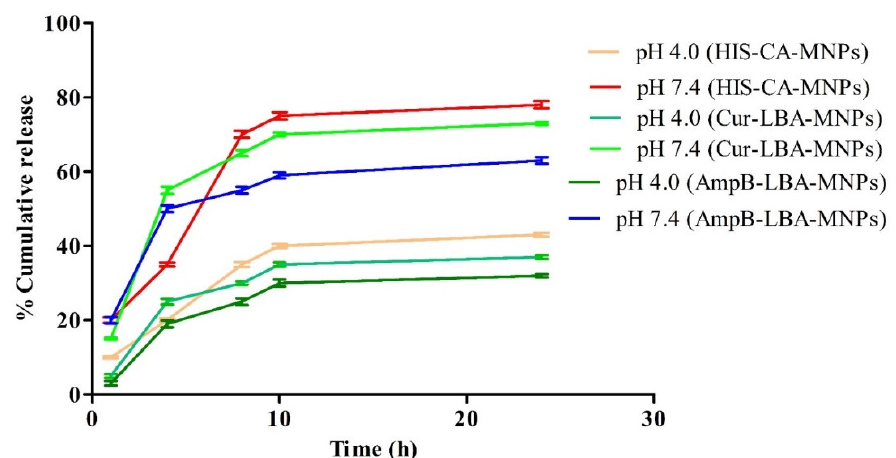
Figure 7. In vitro release profiling of HES, CUR, and AmpB from CA-MNPs and LBA-MNPs nanostructures at different pH.